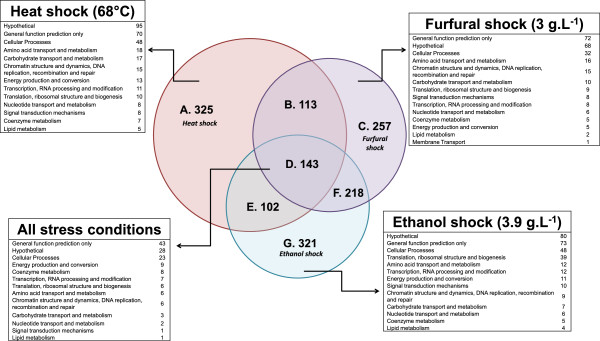
Comparison of transcriptome response of C. thermocellum 27405 to ethanol, furfural and heat shock relative to untreated control fermentations. Genes were categorized into functional groups based on COG assignment and listed for those genes exclusively affected in each treatment or affected in all stresses. A through G categories for each Venn segment is used to cross reference to Additional file 1: Table S1 as listed in the column titled Venn diagram code.